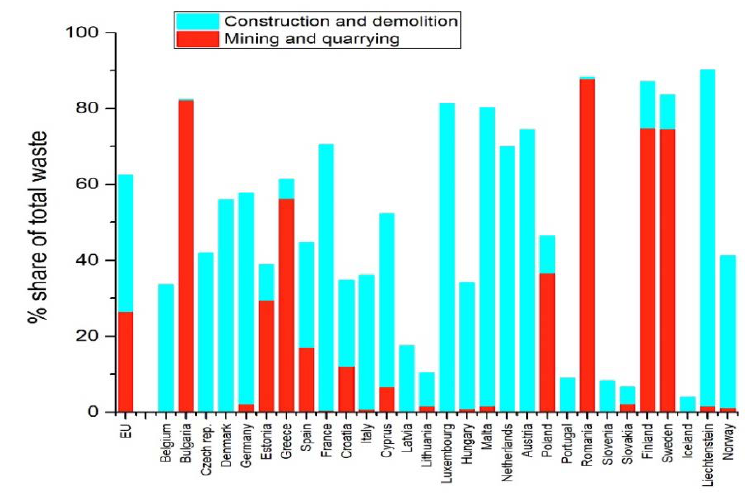
Figure 1. Waste generation by European countries, 2018 [16] .